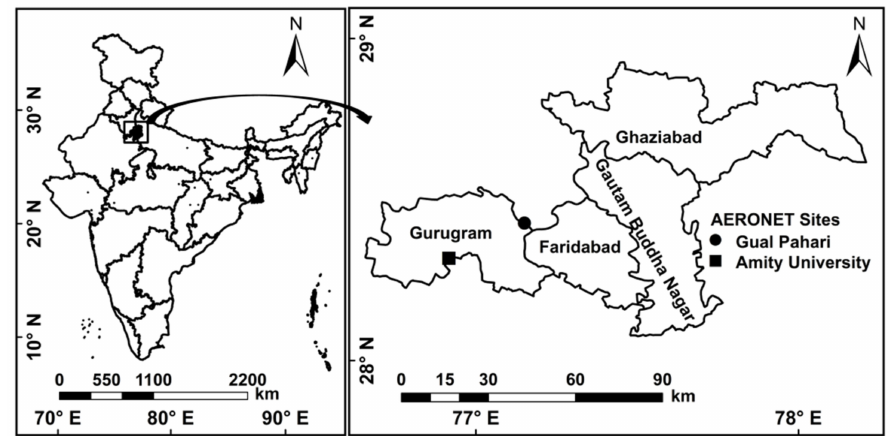
Figure 1. Map of the study